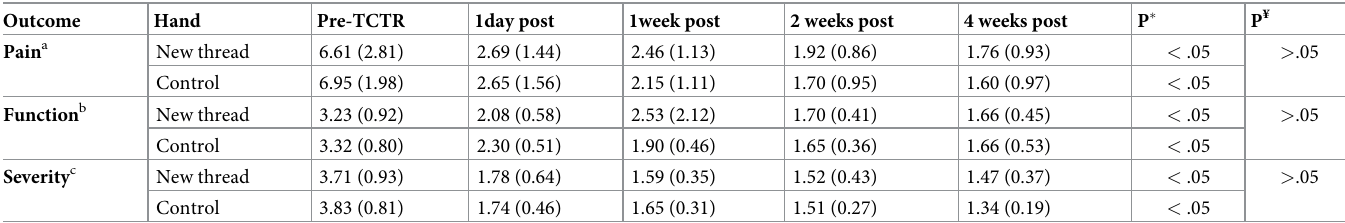
Table 3. Early recovery following TCTR: Mean (SD).